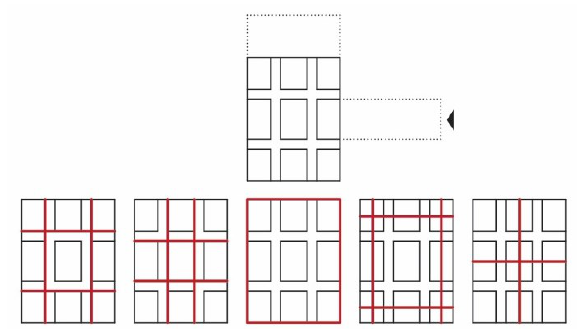
Figure 12. Position of the section planes. Drawing: F. Natta These sections are positioned along the perimeter walls, along the main axes of symmetry, in the tangency of the bands and in the middle of each vault.